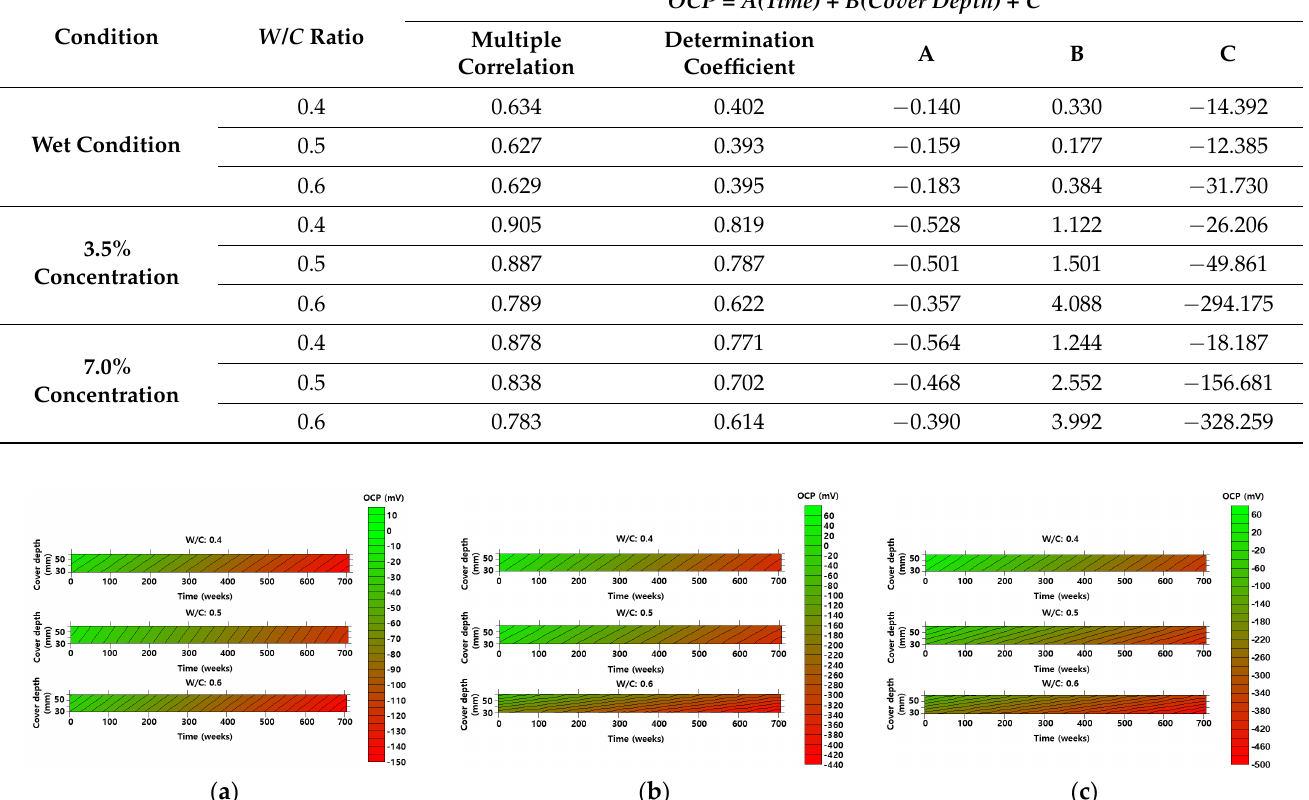
Figure 13 . Regression analysis of the corrosion parameters for open-circuit potential (OCP): ( a ) wet condition, ( b ) 3.5% concentration, and ( c ) 7.5% concentration.